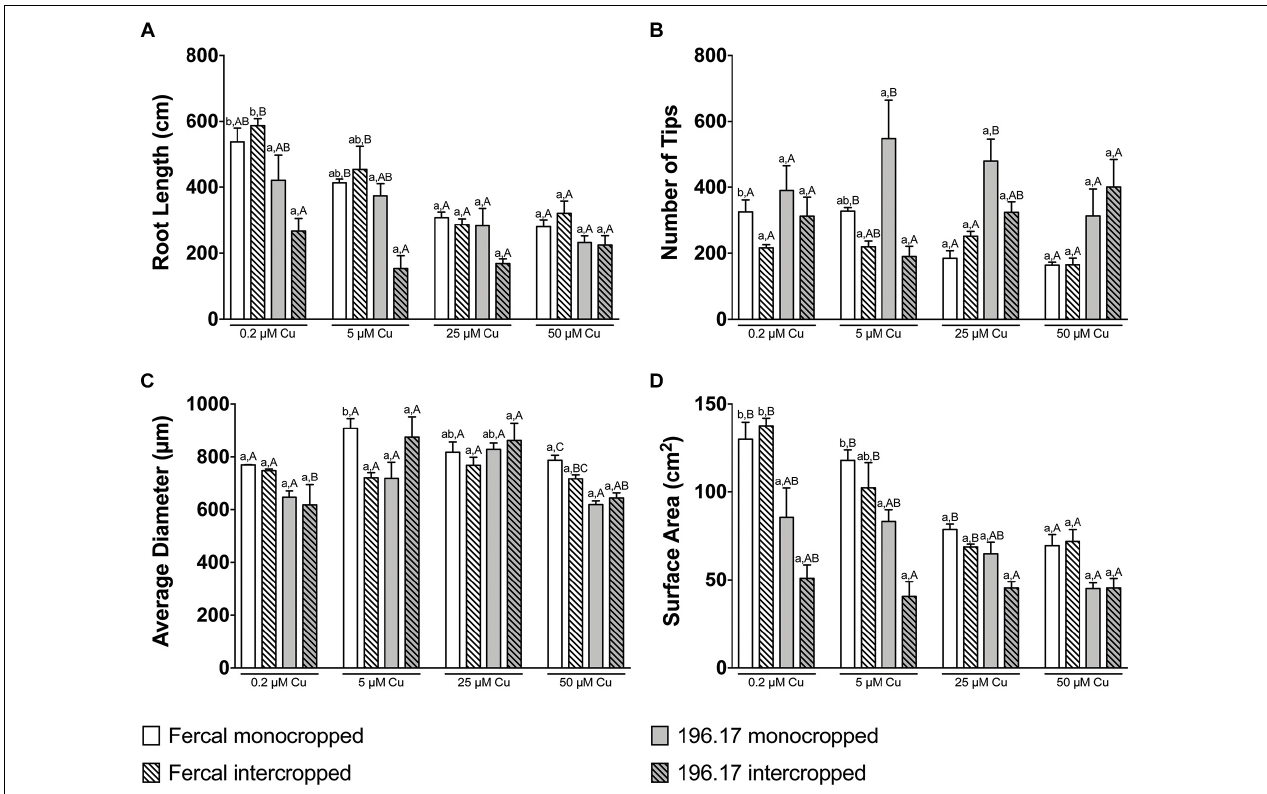
FIGURE 3 | Root architecture parameters of Fercal and 196.17 rootstock plants, either monocropped or intercropped with oat, ad exposed to increasing concentration of Cu. (A) Total root length. The statistical significance of the whole dataset was tested by a three-way ANOVA test: Cu concentration p < 0.0001; Genotype p < 0.0001; Cropping system p = 0.0155; Cu concentration × Genotype p = 0.0189; Cu concentration × Cropping system p = 0.2533; Genotype × Cropping system p = 0.0002; Cu concentration × Genotype × Cropping system p = 0.2004. (B) Total number of tips. The statistical significance of the whole dataset was tested by a three-way ANOVA test: Cu concentration p = 0.3870; Genotype p < 0.0001; Cropping system p = 0.0033; Cu concentration × Genotype p = 0.3179; Cu concentration × Cropping system p = 0.0051; Genotype × Cropping system p = 0.1043; Cu concentration × Genotype × Cropping system p = 0.0617. (C) Average diameter. The statistical significance of the whole dataset was tested by a three-way ANOVA test: Cu concentration p < 0.0001; Genotype p = 0.0107; Cropping system p = 0.3830; Cu concentration × Genotype p = 0.0063; Cu concentration × Cropping system p = 0.9896; Genotype × Cropping system p = 0.0025; Cu concentration × Genotype × Cropping system p = 0.0229. (D) Total surface area. The statistical significance of the whole dataset was tested by a three-way ANOVA test: Cu concentration p < 0.0001; Genotype p < 0.0001; Cropping system p = 0.0008; Cu concentration × Genotype p = 0.0003; Cu concentration × Cropping system p = 0.0681; Genotype × Cropping system p = 0.0132; Cu concentration × Genotype × Cropping system p = 0.2807. Data have been collected at harvest (14 days after Cu treatment) and are reported as means ( ± SE), n = 5. Different letters indicate significantly different values as determined using one-way ANOVA with Tukey post hoc tests ( p < 0.05). Lower-case letters account for statistical analyses of the same cropping system exposed to different Cu concentrations. Upper-case letters account for statistical analyses of the different